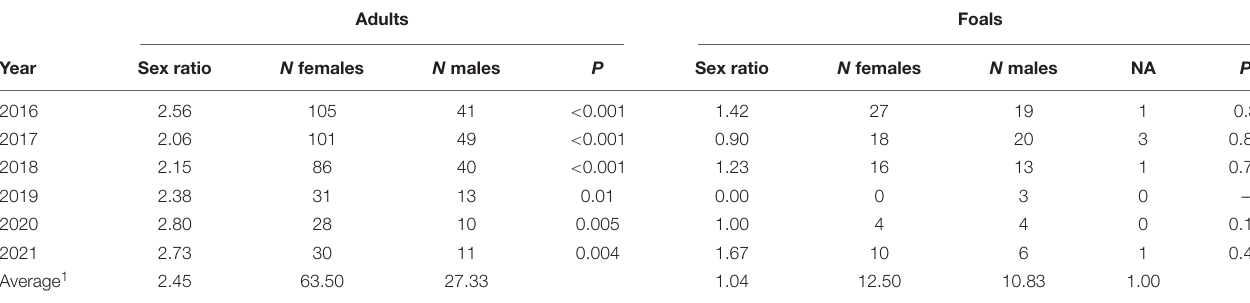
TABLE 5 | Female reproductive performance, adults’ and foals’ sex ratios over 6 breeding seasons.